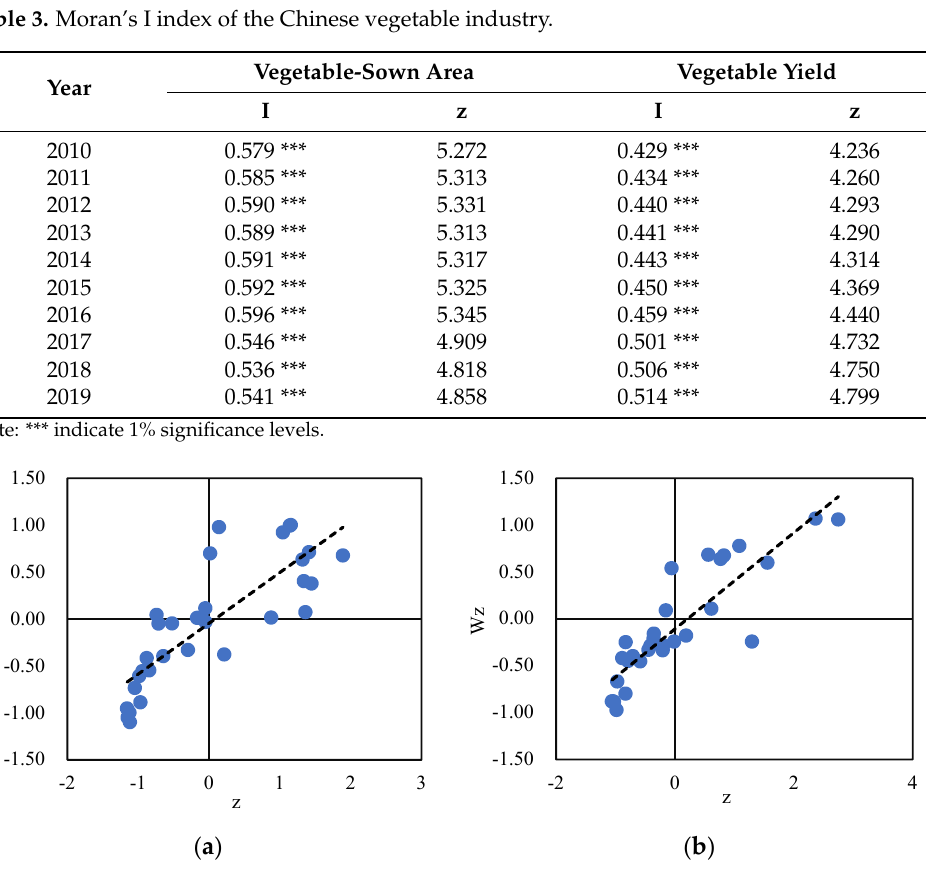
( b ) Figure 6. Shift chart of vegetable production center in China: ( a ) vegetable-sown area; ( b ) vegetable yield.